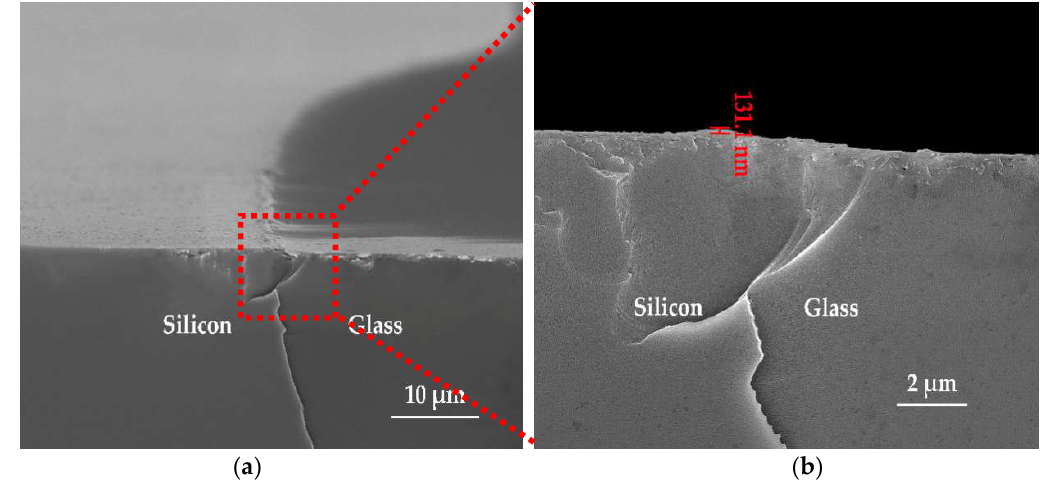
Figure 9. SEM cross-sectional view of the silicon-glass interface prepared with the optimized scheme. ( a ) Silicon-glass interface taken with 5000× magnification; ( b ) close-up view of the silicon-glass interface in (a).